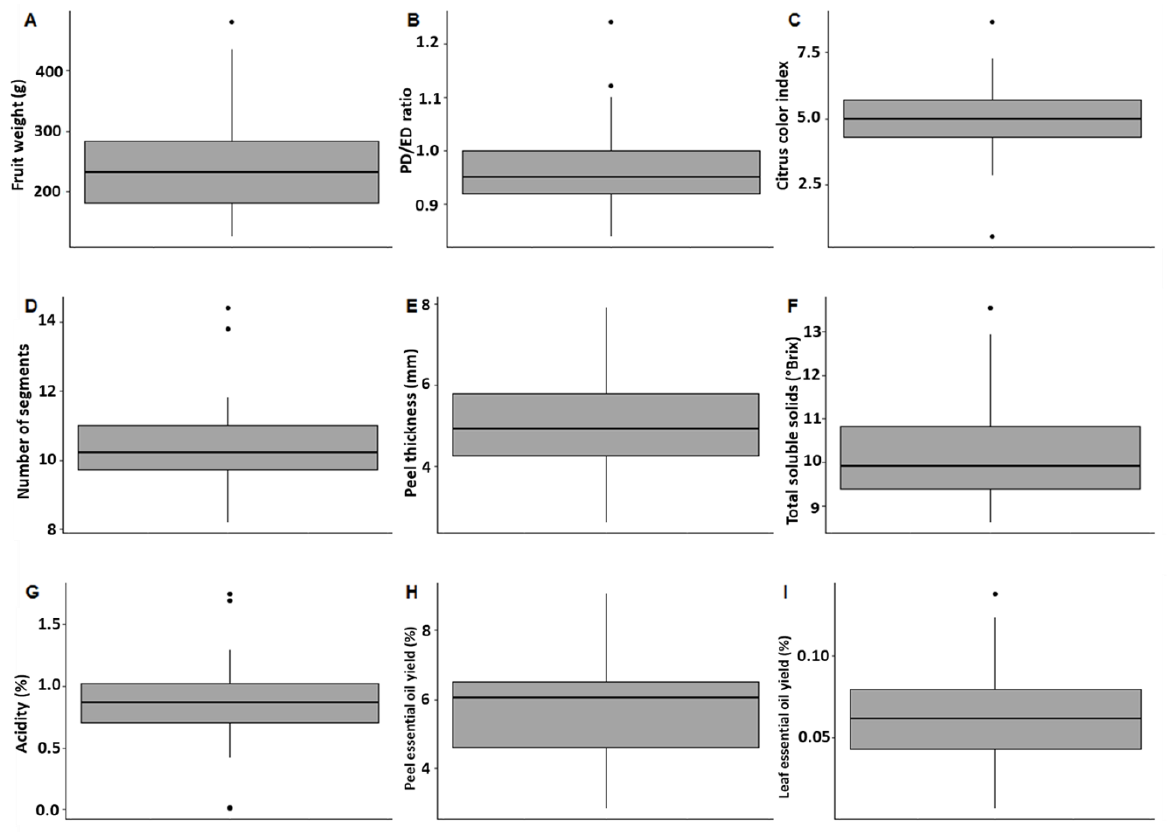
Figure 1. Boxplots representing the distribution of different phenotypic traits among 43 orange cultivars. ( A ) fruit weight, ( B ) fruit shape, ( C ) external fruit peel color, ( D ) number of fruit segments, ( E ) peel thickness, ( F ) total soluble solids, ( G ) titrated acidity, ( H ) yield of PEO, and ( I ) yield of LEO. PD: polar diameter, ED: equatorial diameter.